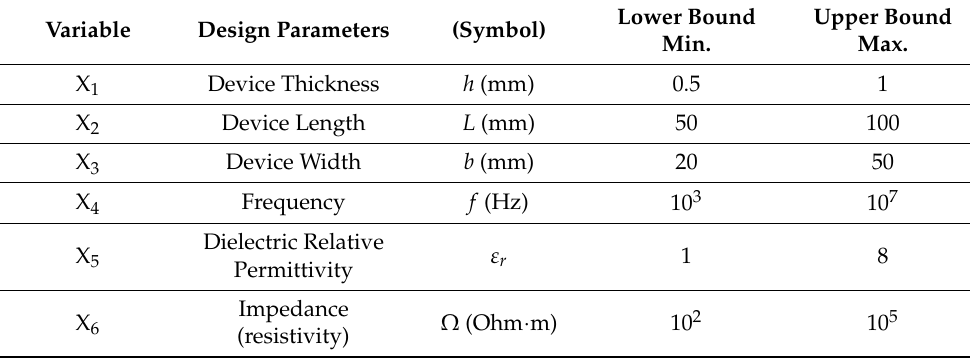
Table 2. Domains and characteristics of the variables.